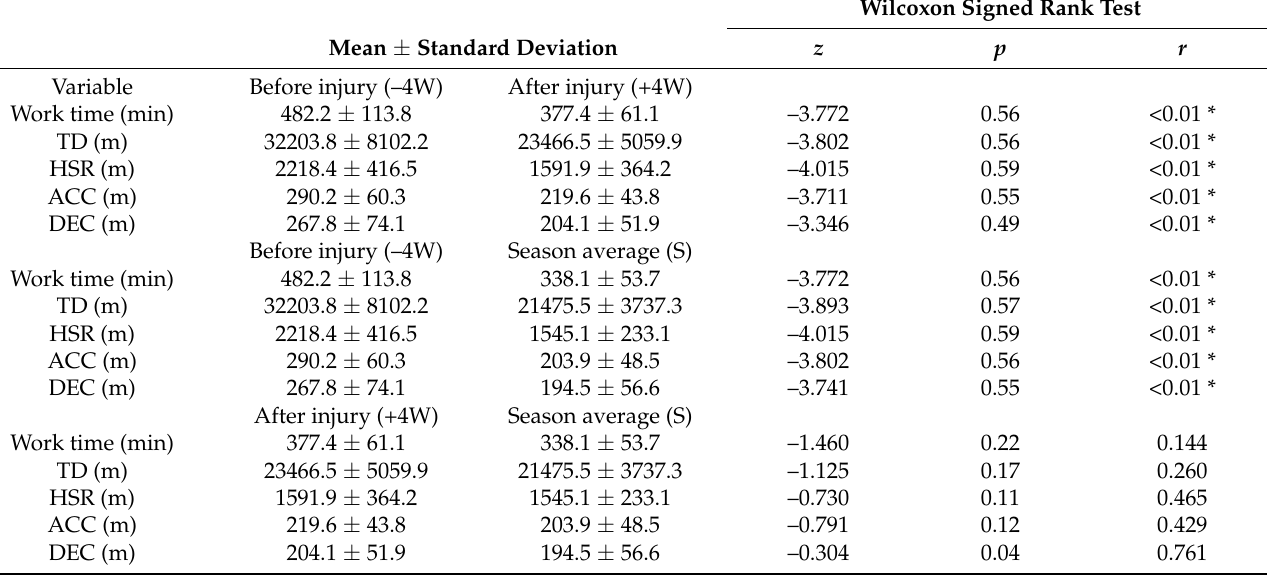
Table 4. Descriptive statistics and Wilcoxon signed rank test for GPS metrics in weekly performances ( n =